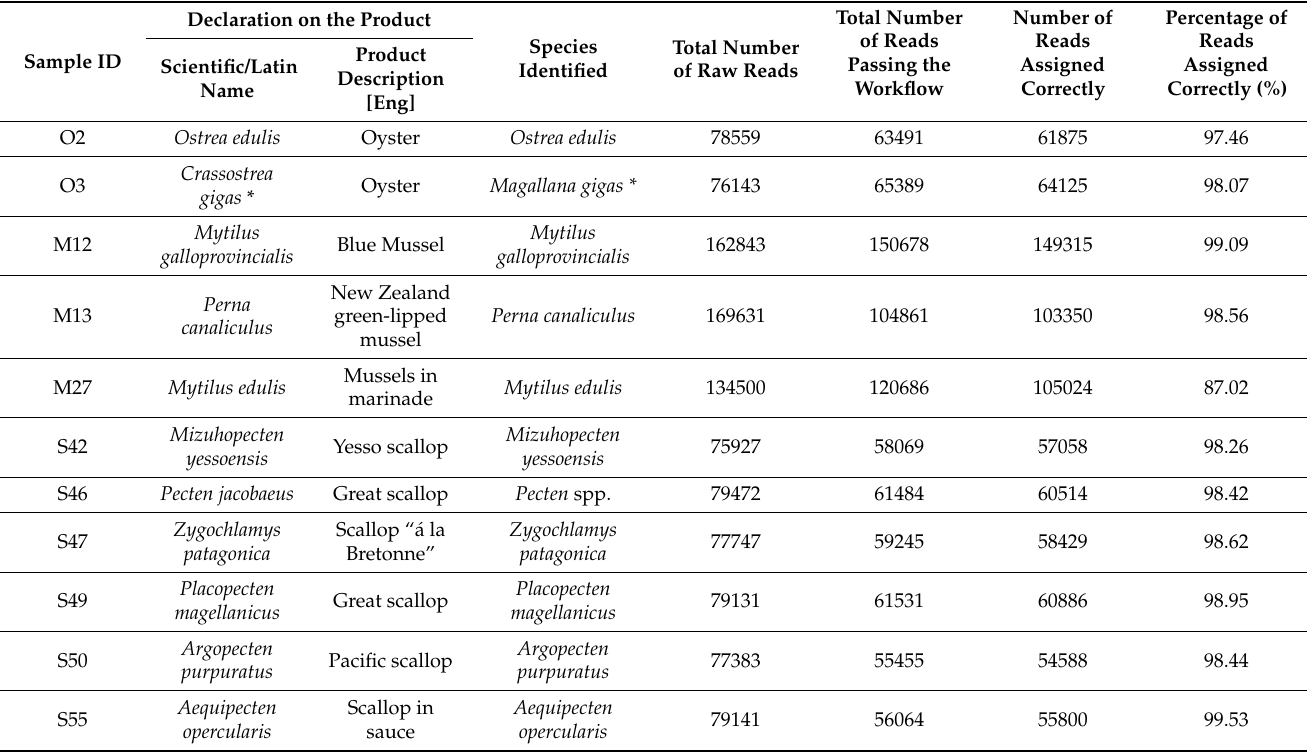
Table 3. Results for DNA extracts from reference samples. Numbers are mean values ( n = 6, three sequencing runs, two replicates per run).